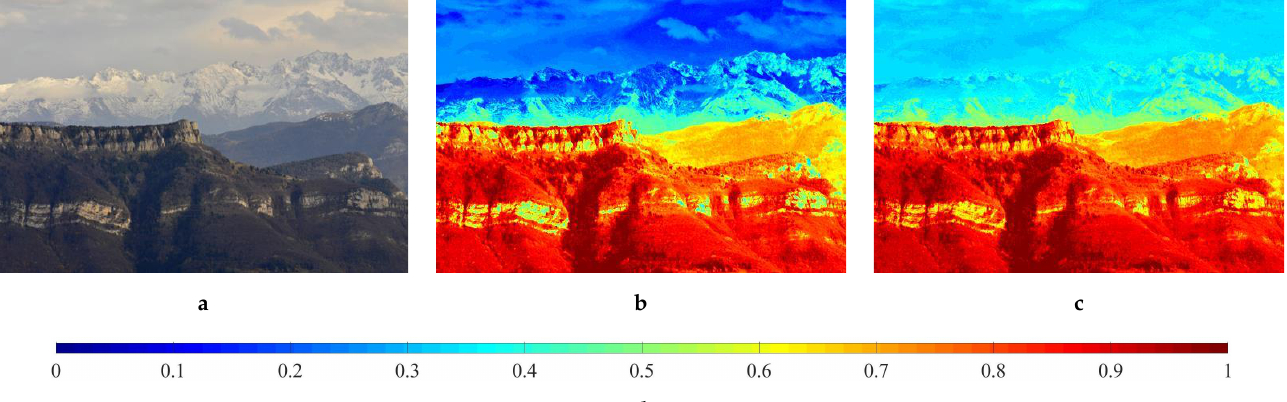
Figure 7. Illustration of a hazy image and its corresponding transmission map estimates. ( a ) Hazy image, and its ( b ) transmission map estimate based on the dark channel, ( c ) optimal transmission map derived in this study, and ( d ) reference color